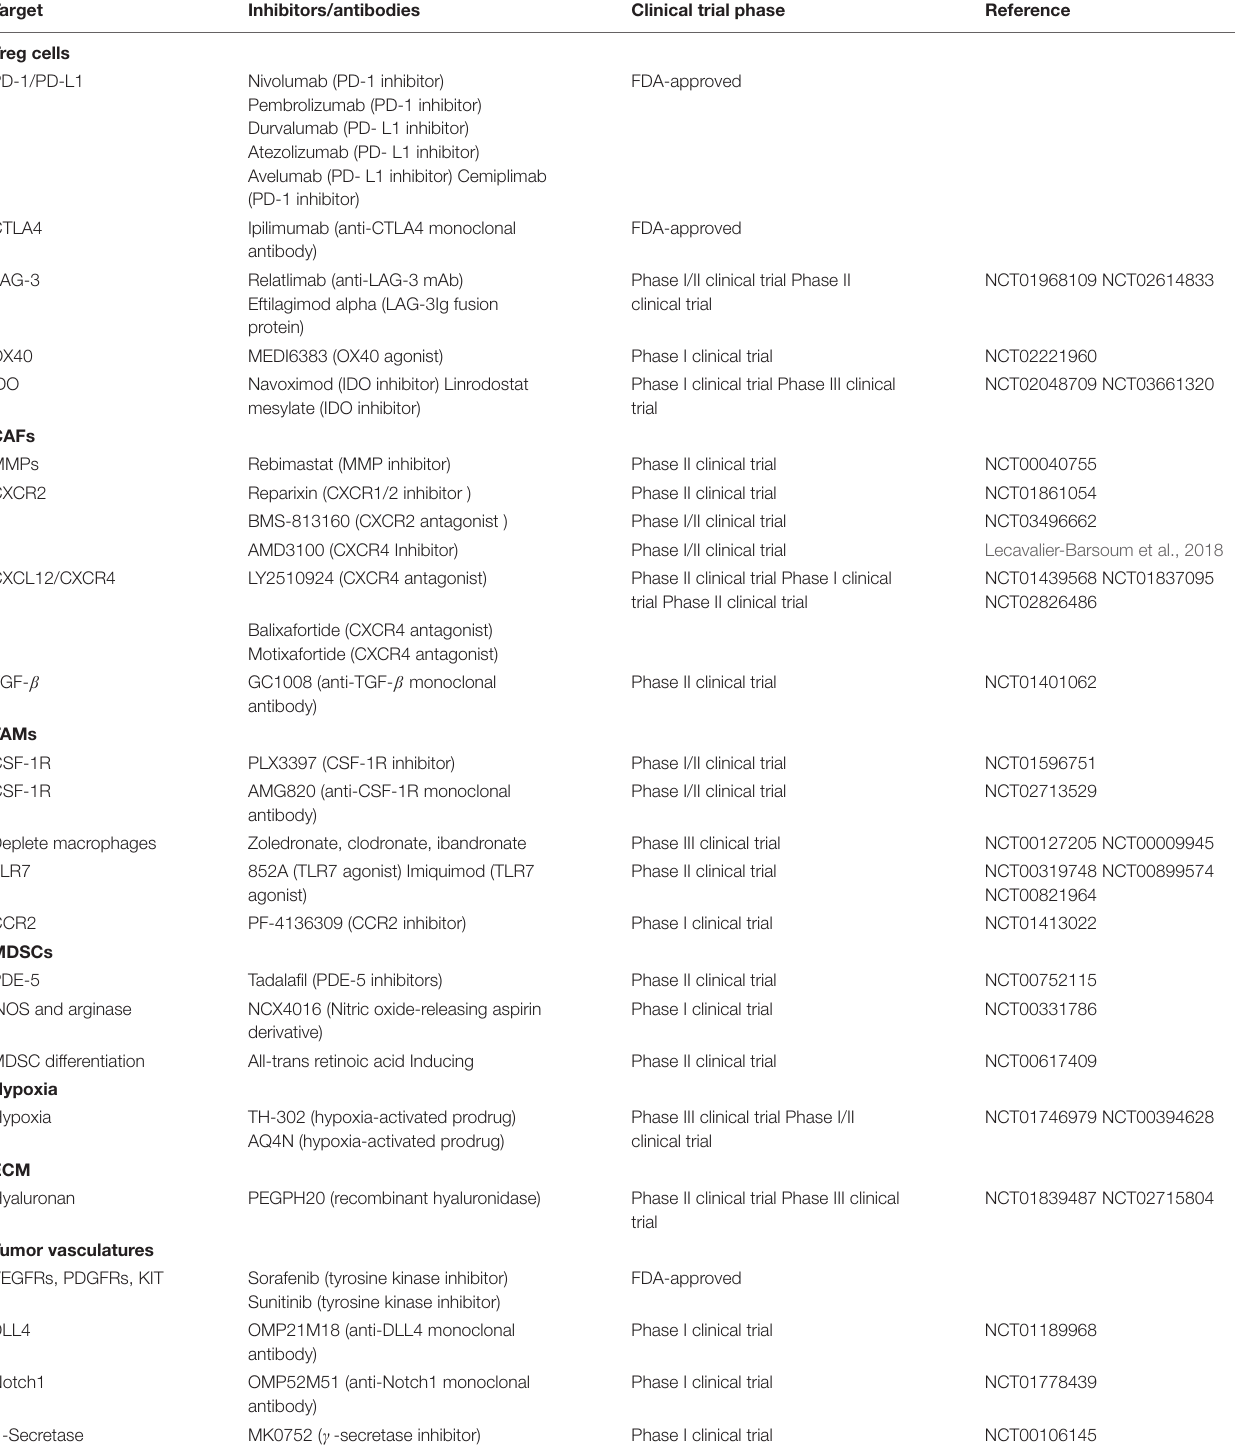
TABLE 1 | Most recent clinical trials of TME targeted